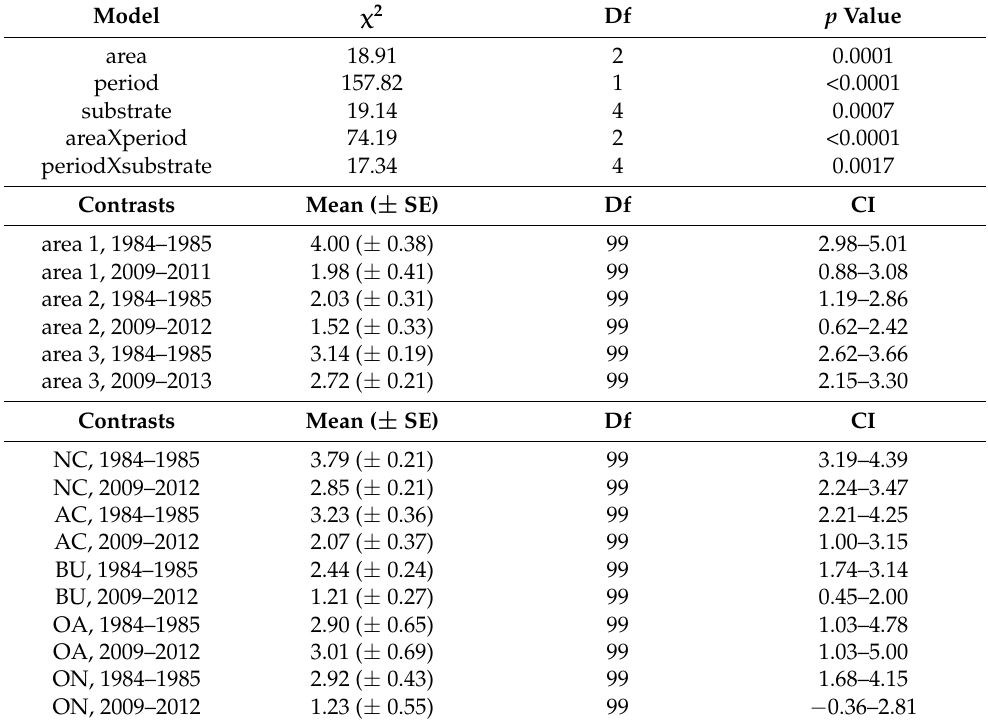
Table 3. Model and post hoc tests (contrasts) obtained to assess changes in the number of breeding jackdaws from 1994–1997 to 2009–2011 (period) in the three areas (area) within the study region and in different substrates (NC: natural cliffs, AC: artificial cliffs, BU: buildings, OA: other artificial structures, ON: other natural substrates). Mean: estimated marginal means; SE: standard errors; CI: confidence intervals. Model fits are shown in Figures S1 and S2.